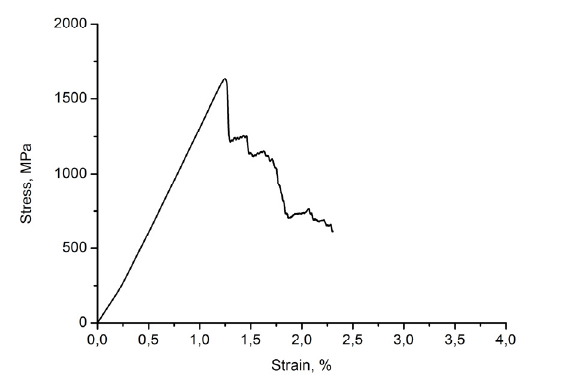
Figure 3: The   diagram in the case of the lateral pressure.